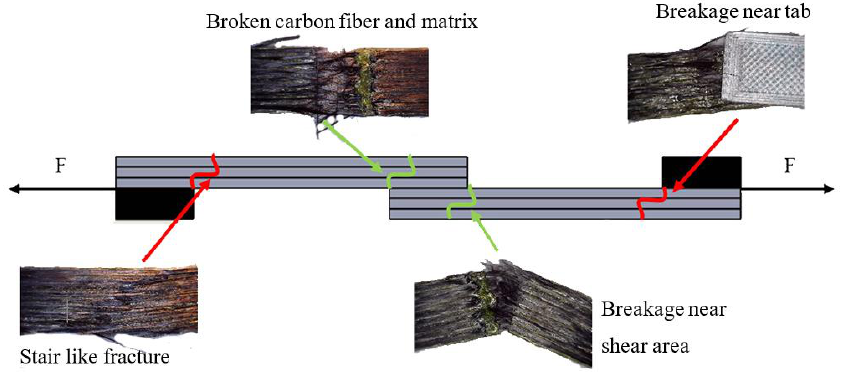
Figure 9. Schematic diagram of specimen fracture patterns.